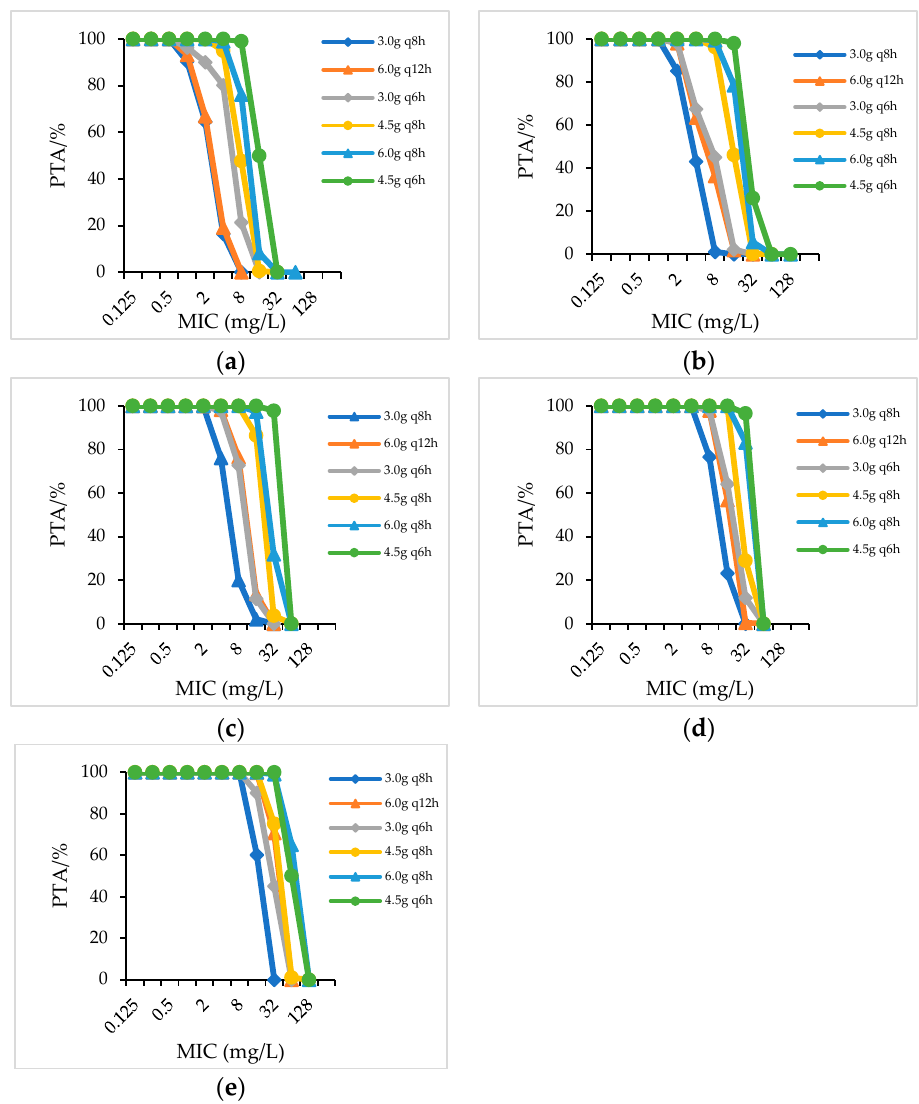
Figure 1. PTA for PIS in patients with different renal functions. ( a ) CrCL > 90 mL/min; ( b ) CrCL 60–90 mL/min; ( c ) CrCL 40–59 mL/min; ( d ) CrCL 20–39 mL/min; ( e ) CrCL < 20